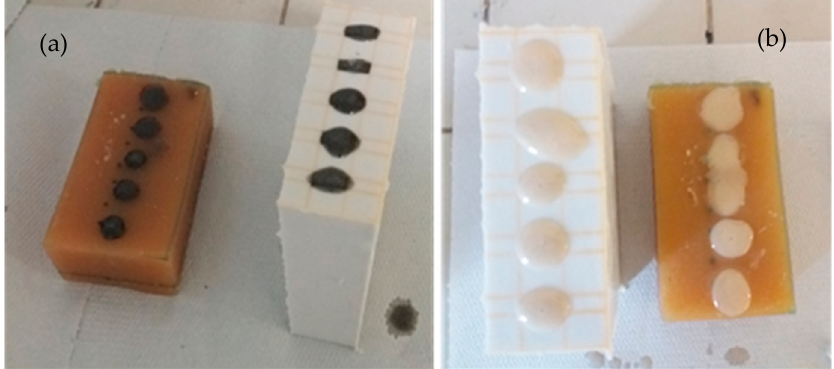
Figure 2. Specimen preparation: ( a ) stabilized sample-composite material, ( b ) CaCO 3 -composite material.